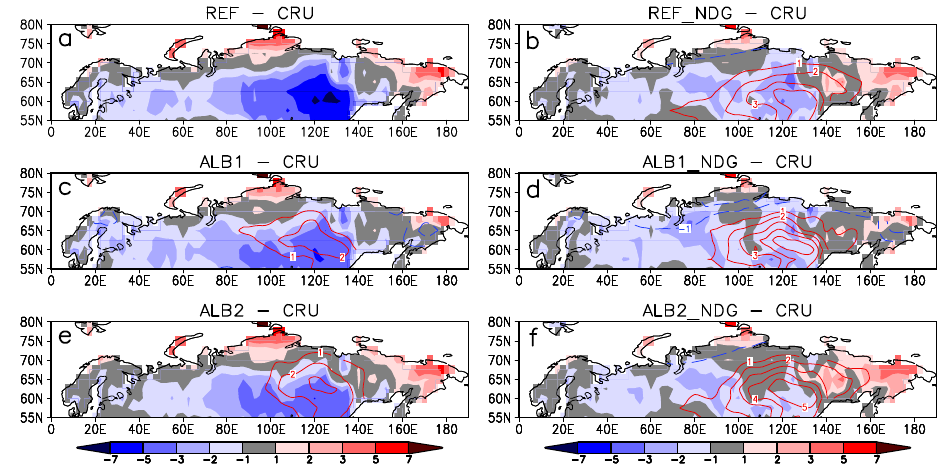
Figure 12. Differences in April–May mean 2m air temperature between ECHAM5 and the CRUTEM3 data set for the (a) REF, (b) REF_NDG, (c) ALB1, (d) ALB1_NDG, (e) ALB2 and (f) ALB2_NDG experiments. The contours in (b – f) indicate the difference from the REF experiment (contour interval 1K; zero contour